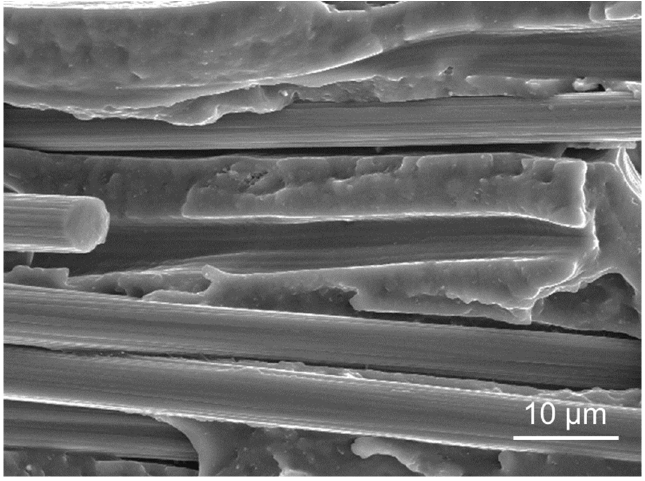
Figure 14. Fiber debonding observed on fracture surfaces of 90° layers.